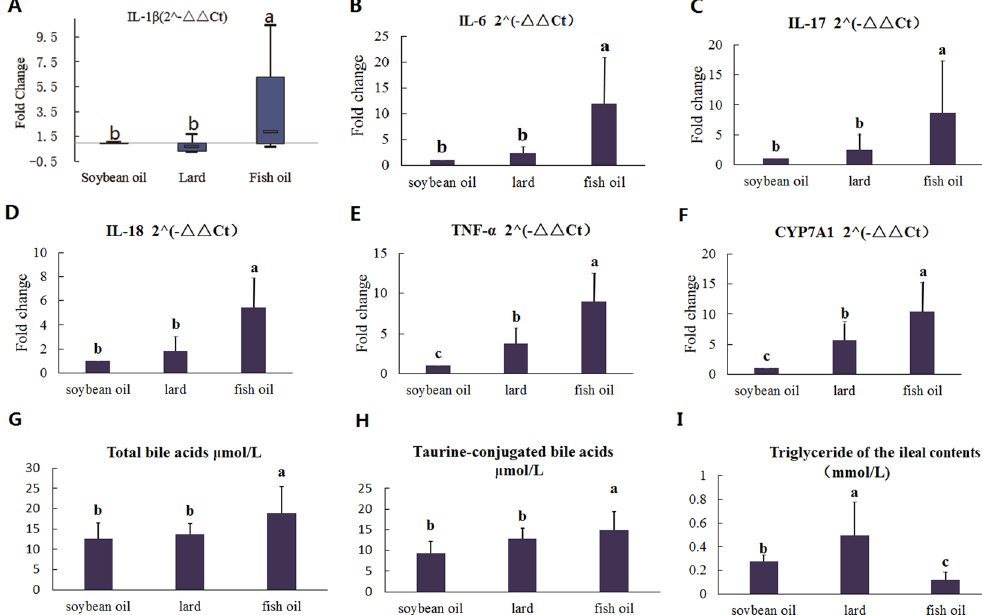
Figure 3. Diet-induced changes of physiological parameters of the rats. ( A–E ) The expression of inflammatory cytokines in the colon tissue, including IL-1 β ( A ), IL-6 ( B ), IL-17 ( C ), IL-18 ( D ) and TNF- α ( E ). ( F ) The expression of gene CYP7A1 in the liver. ( G ) The amounts of total bile acids in the caecal contents. ( H ) The amounts of taurine-conjugated bile acids in the caecal contents. ( I ) The amounts of triglyceride in the ileal contents The data were analyzed by one-way analysis of variance and means were compared by the procedure of Duncan’s multiple-range comparison. a,b,c, means with different letters differed significantly (p < 0.05). Error bar means standard